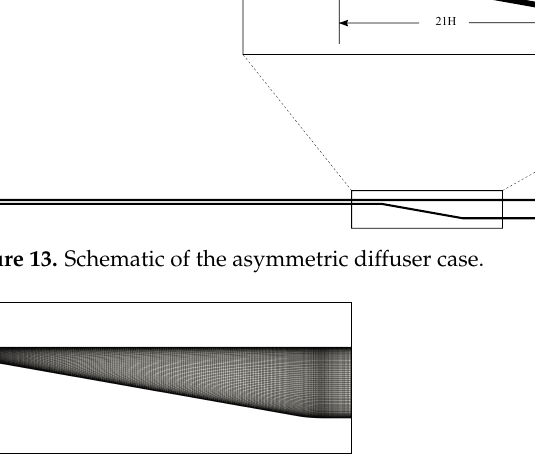
Figure 14. Mesh at the expansion section of the diffuser.